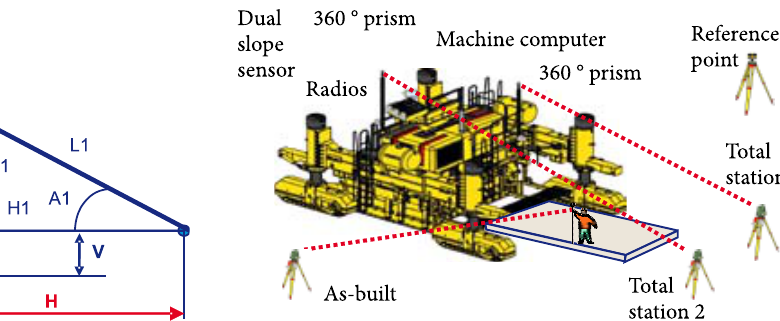
Fig. 3. Calculation of the excavator bucket (Leica digsmart user manual)